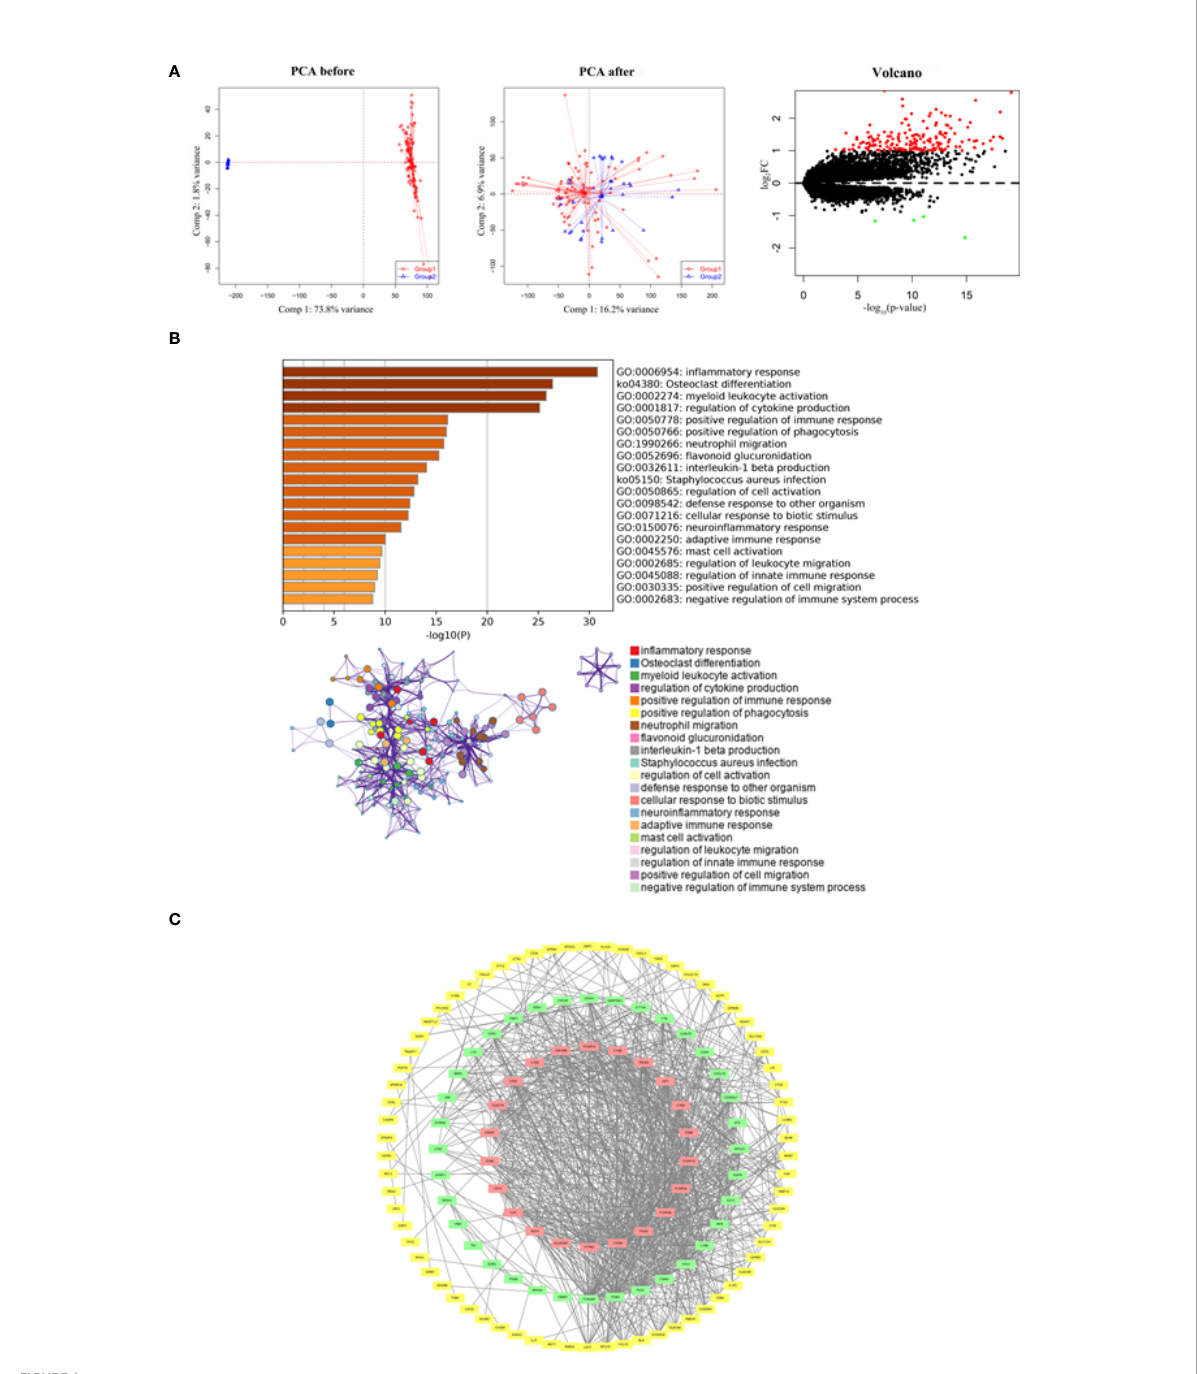
FIGURE 1 Functional enrichment and PPI network analysis of identi fi ed DEGs. (A) Two-dimensional PCA cluster plot of GSE5296 and GSE47681 datasets before and after normalization: group1 represented the SCI group and. group2 represented the normal control group. Red dots represent up- regulated genes, black dots represent no signi fi cant difference, and green dots represent down-regulated genes. (B) GO enrichment analysis demonstrated the main biological process and signaling pathways. (C) The PPI network construction. The red squares construct the most signi fi cant cluster, the green squares represent other clusters, and the yellow squares represent the genes not involved in cluster